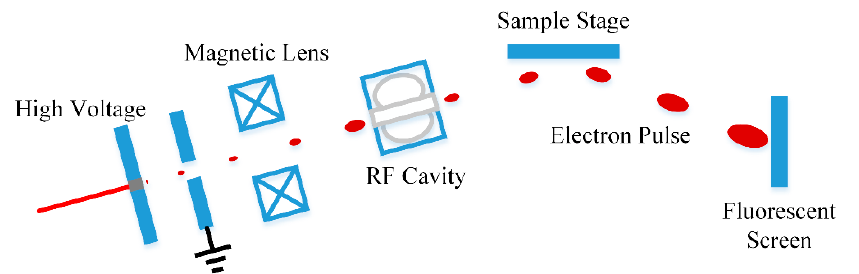
Figure 1. System layout of RF compression ultra-fast electron